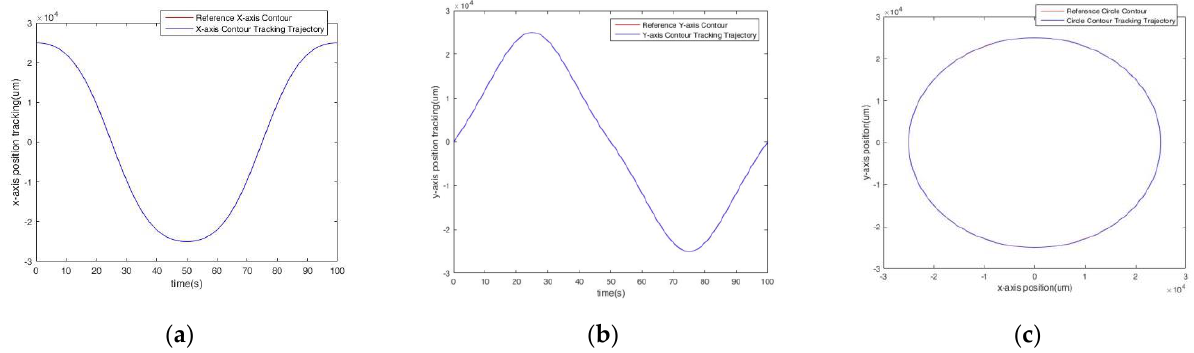
Figure 11. The path trajectory of the experiments. ( a ) The X-axis tracking response, ( b ) the Y-axis tracking response, ( c ) the circle path response.